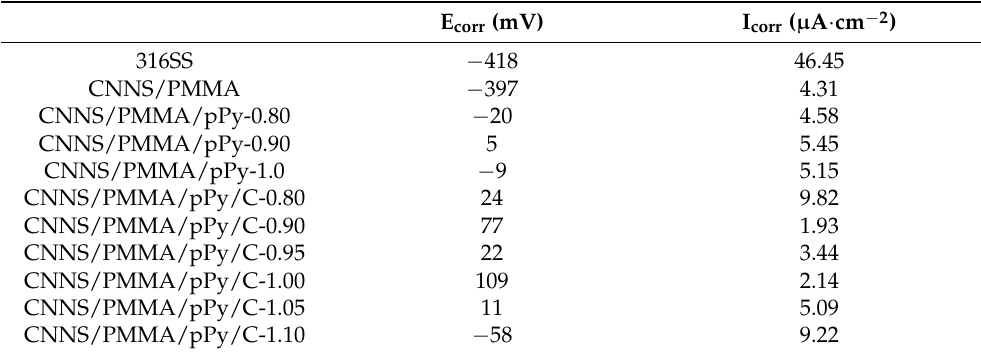
Figure 4. Potentiodynamic polarization of bare 316SS and coated 316SS. Table 1. Fitting parameters of potentiodynamic polarization curves for different